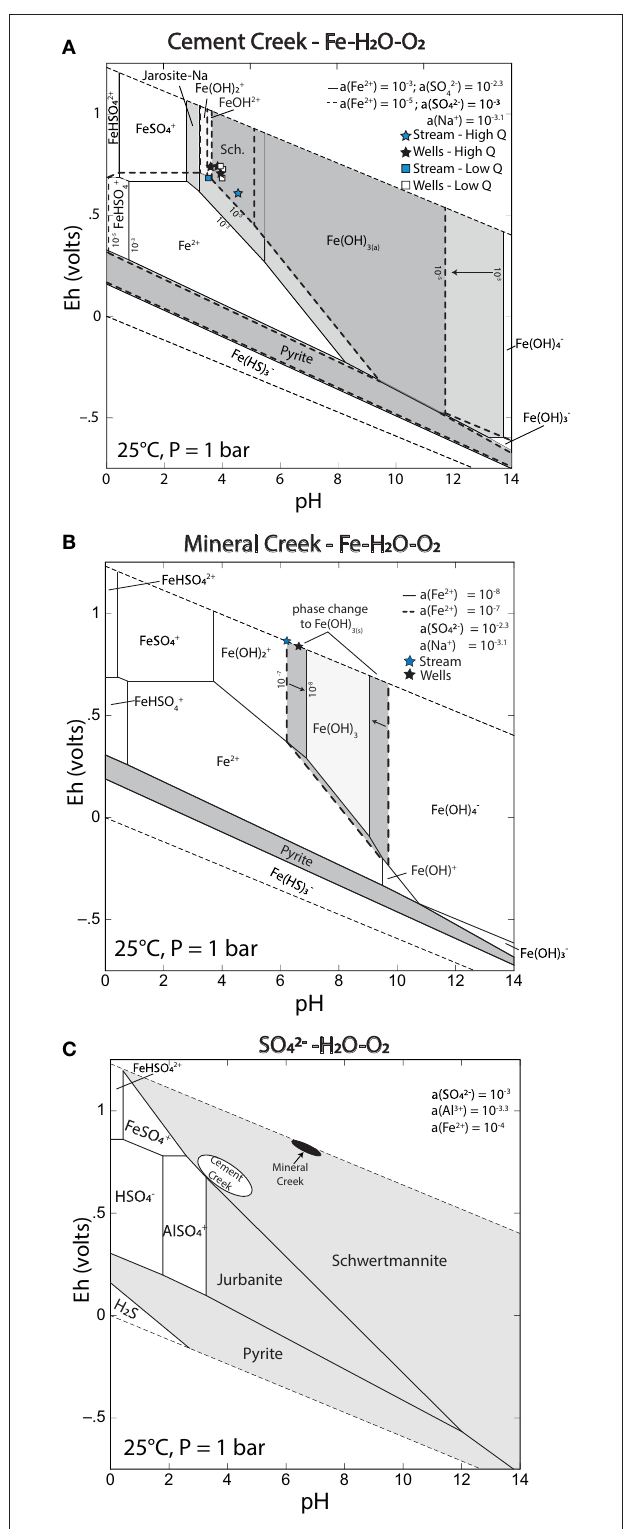
FIGURE 6 | Eh–pH diagrams calculated in Geochemist’s Workbench for Fe at (A) Cement Creek and (B) Mineral Creek and for (C) SO 2 − 4 at Mineral Creek